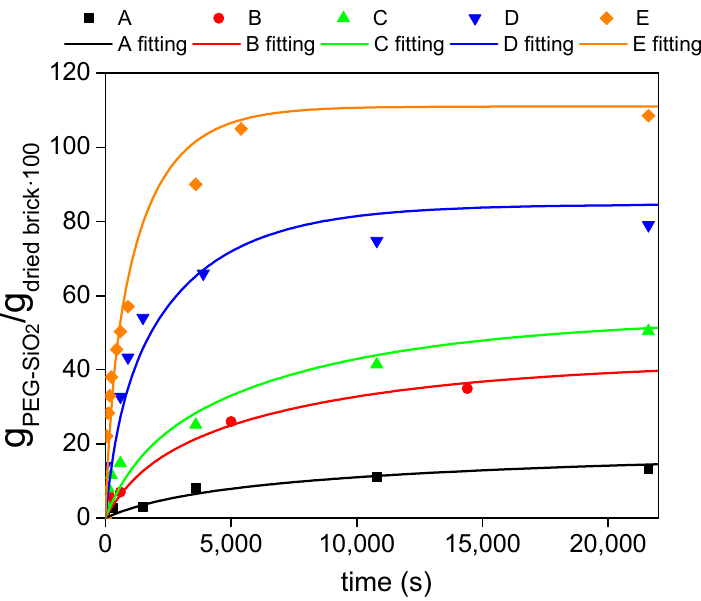
Figure 7. Experimental and modelled kinetic curves of PEG-SiO 2 uptake by bricks having different porosities.